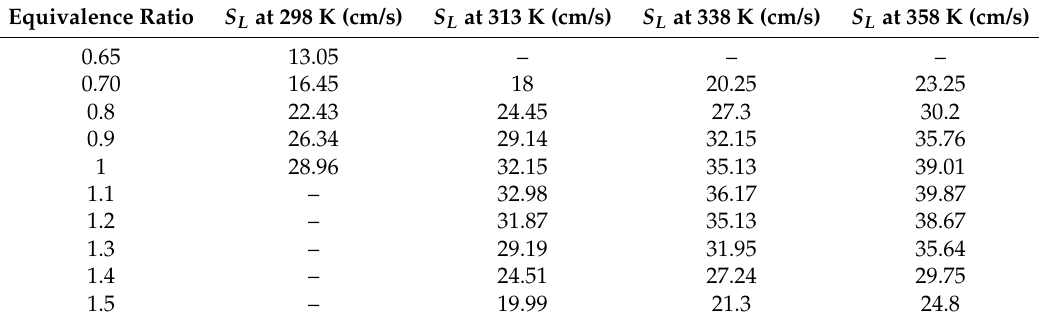
Table 3. Laminar burning velocities of DMC with air at 298 a , 313, 338, and 358 K [73]. Equivalence